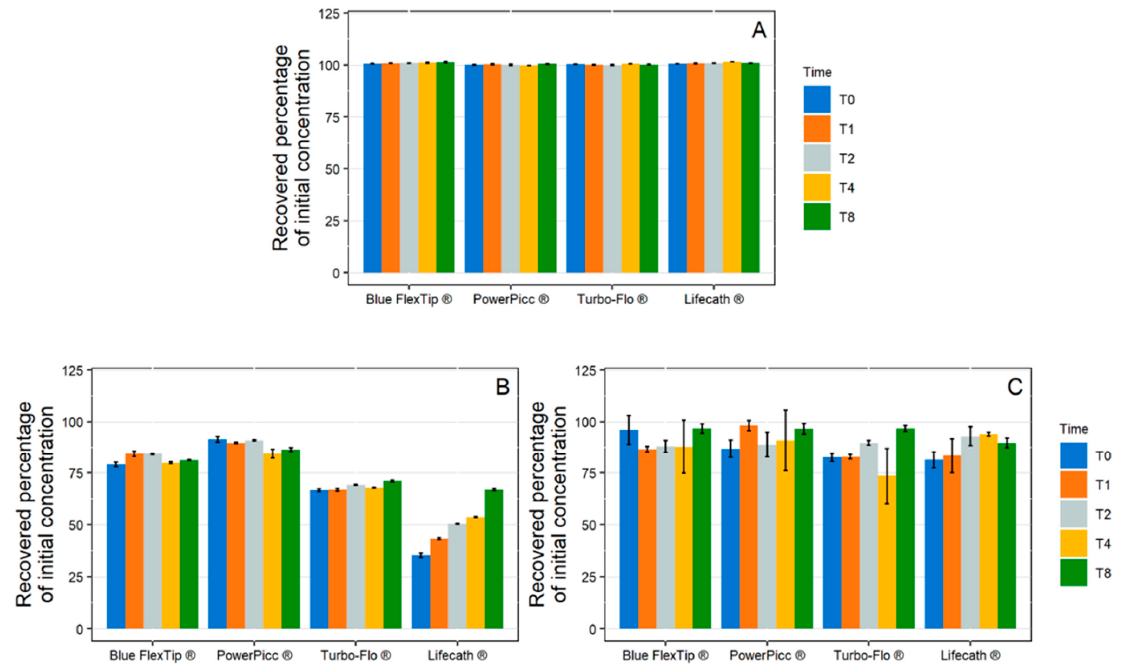
Figure 4. Evolution of the recovered percentage of initial concentration in paracetamol ( A ), diazepam ( B ), and insulin ( C ) in 10 mL/h dynamic condition with polyurethane catheters (Blue FlexTip ® , PowerPicc ® , and Turbo-Flo ® ) and a silicone catheter (Lifecath ® ). ( n = 3, mean ± standard error of the mean). T0–T8: different analysis times: immediately after purging (T0), then after 1 h (T1), 2 h (T2), 4 h (T4), and 8 h (T8) of infusion.